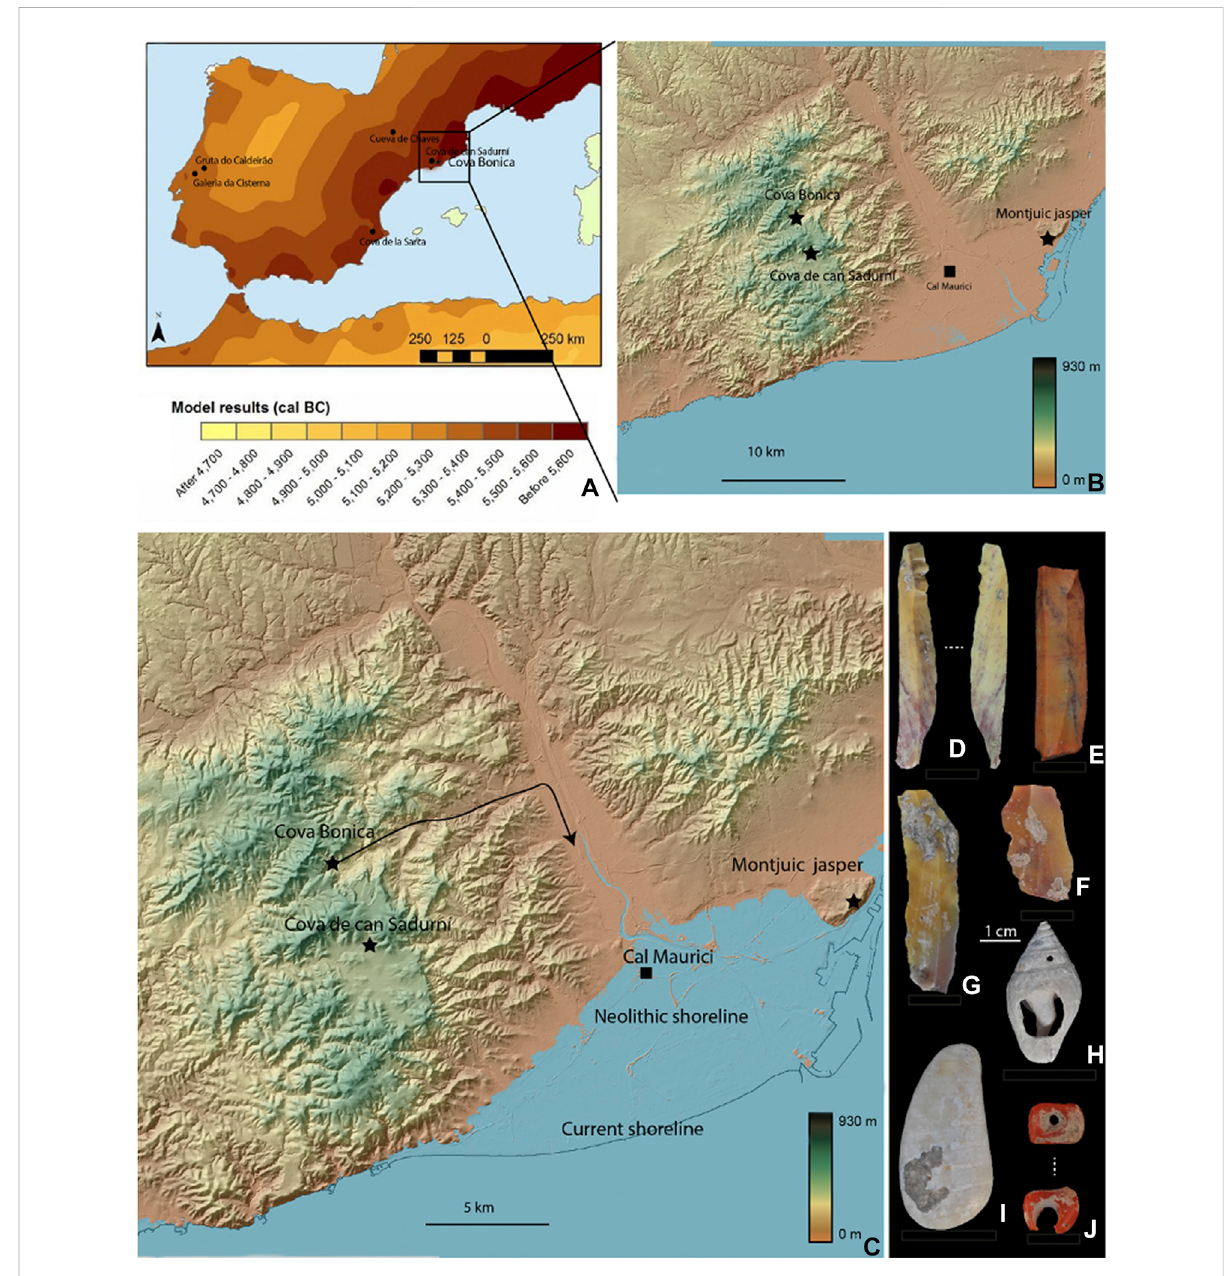
FIGURE 6 Cova Bonica in the context of regional settings. (A) : Model predictions for the Neolithic expansion: leapfrog voyaging with jumps of about 350 km(Isernetal.,2017). (B – C) :Digitalelevationmodel(DEM)constructedusingGISversion3.24.2andsignalingcurrentcoastline (B) andneolithic shoreline (C) . Neolithic shoreline has been established using data provided from the Cal Maurici site (Daura et al., 2016). (D – G) : Jasper blades and fl akes recovered at layer IV – J) : Marine ornaments recovered at layer IV Columbella 2 coming from Montjuic (Barcelona). (H 2 elaborated from rustica (H) , polished shell (I), and red coral (J)